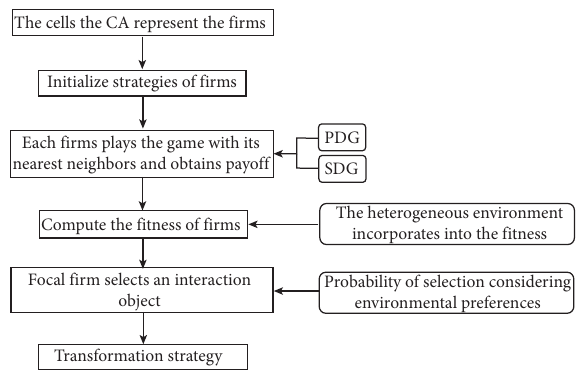
Figure 1: Flowchart of the